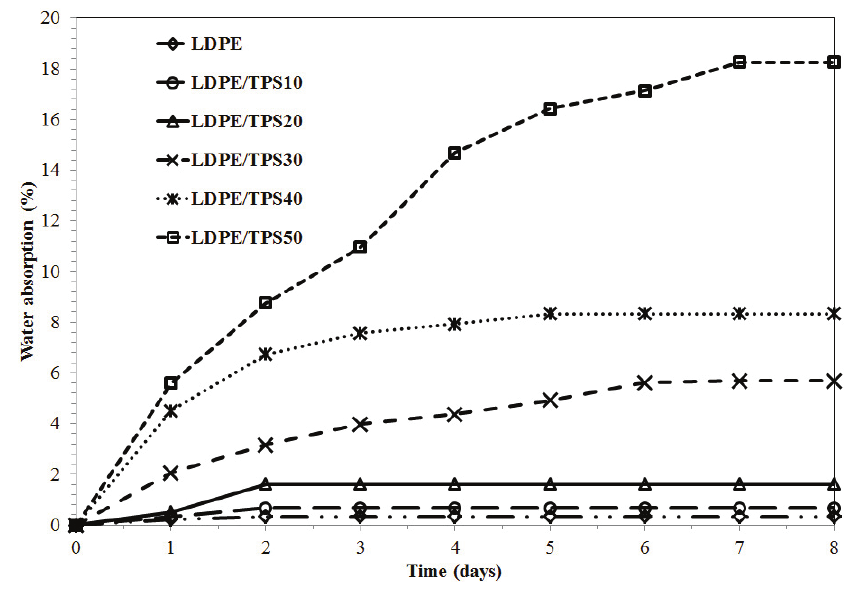
Fig. 11 – Water absorption of the LDPE/TPS blends with immersion time